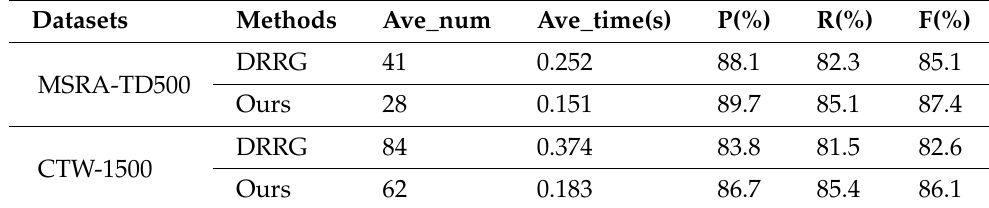
Table 1. Results of ablation experiments involving text component extraction.